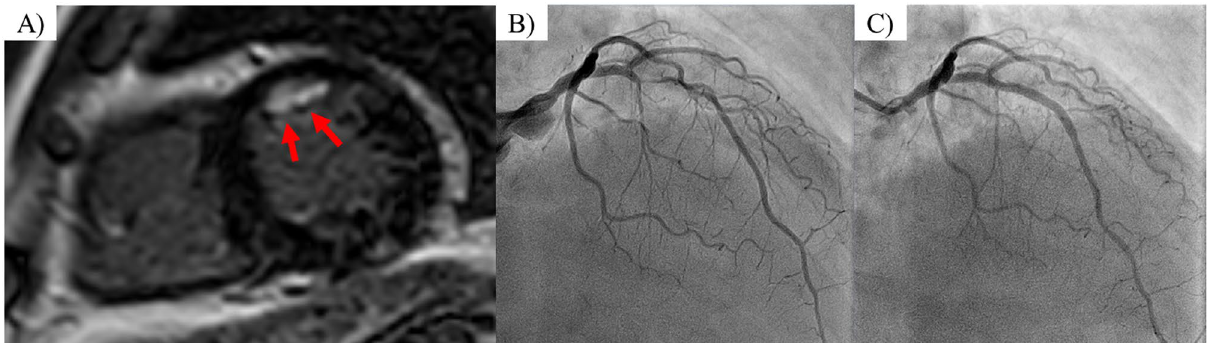
Figure 1. Representative images of patients with unrecognized myocardial infarction. A 69-year-old man with a history of diabetes mellitus with stable coronary artery disease. ( A ) Short-axis view of delayed-enhancement cardiac magnetic resonance imaging with anterior late gadolinium enhancement (arrowheads). ( B ) Pre-PCI angiography showing significant coronary stenosis in the proximal left anterior descending artery. The FFR value was 0.53. ( C ) Post-PCI angiography demonstrating implantation of a drug-eluting coronary stent in the LAD lesion. The FFR value after PCI was 0.91. PCI percutaneous coronary intervention, FFR fractional flow reserve, LAD left anterior descending